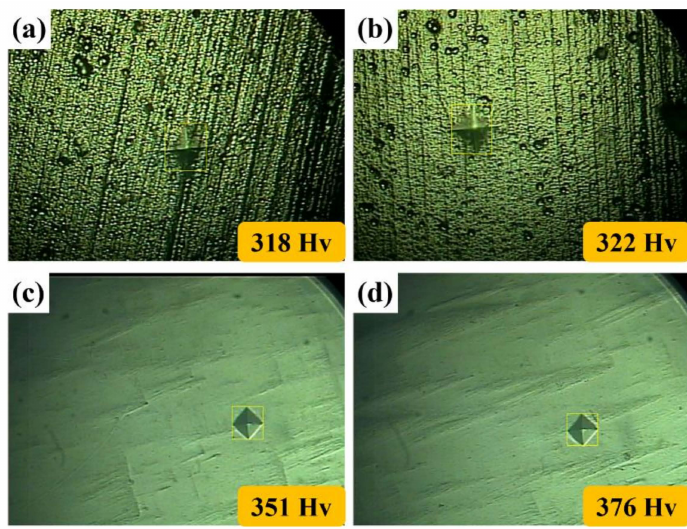
Figure 9. The hardness of ( a ) NAP, ( b ) AP, ( c ) NAPEP20 and ( d ) APEP20 samples. The potentiodynamic polarization curves for NAP, AP, NAPEP20 and APEP20 sam- ples in 3.5 wt.% NaCl solution are shown in Figure 10. Most of the important corrosion parameters are determined from the curve, including the corrosion potential ( E corr ) and the corrosion current density ( i corr ). All of the corrosion parameters that are determined using the potentiodynamic polarization curves are listed in Table 2. The E corr value has a significant effect on the corrosion reaction. A system with a lower E corr value requires less energy to activate a polarization reaction.